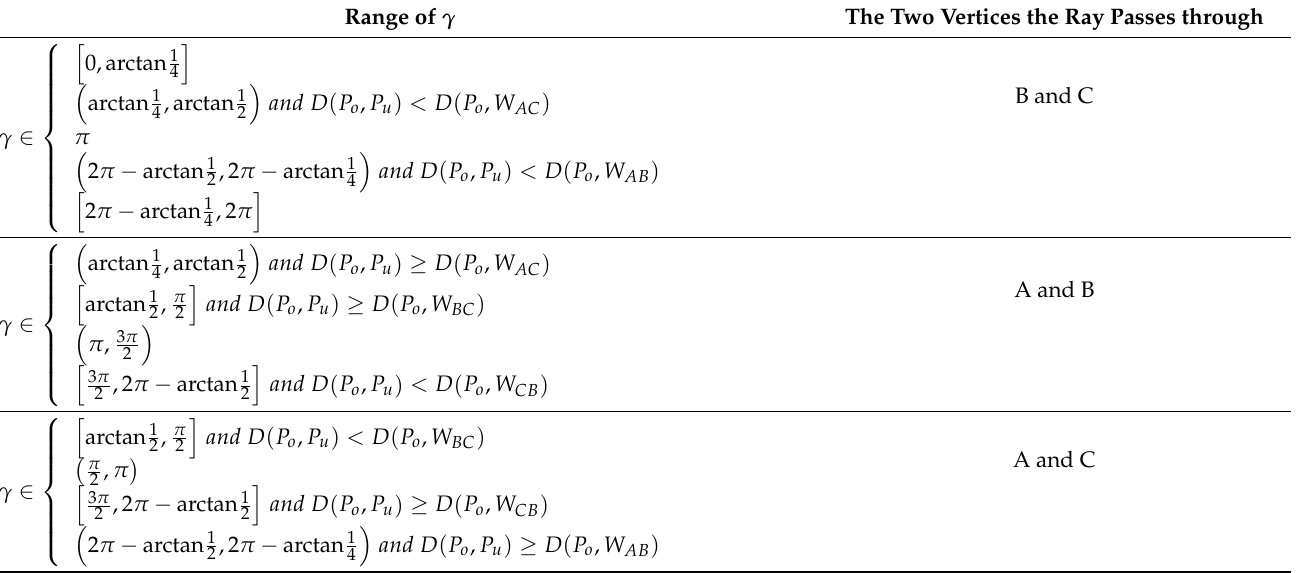
Table 1. Selection of two vertices through which the ray passes. Range of γ The Two Vertices the Ray Passes